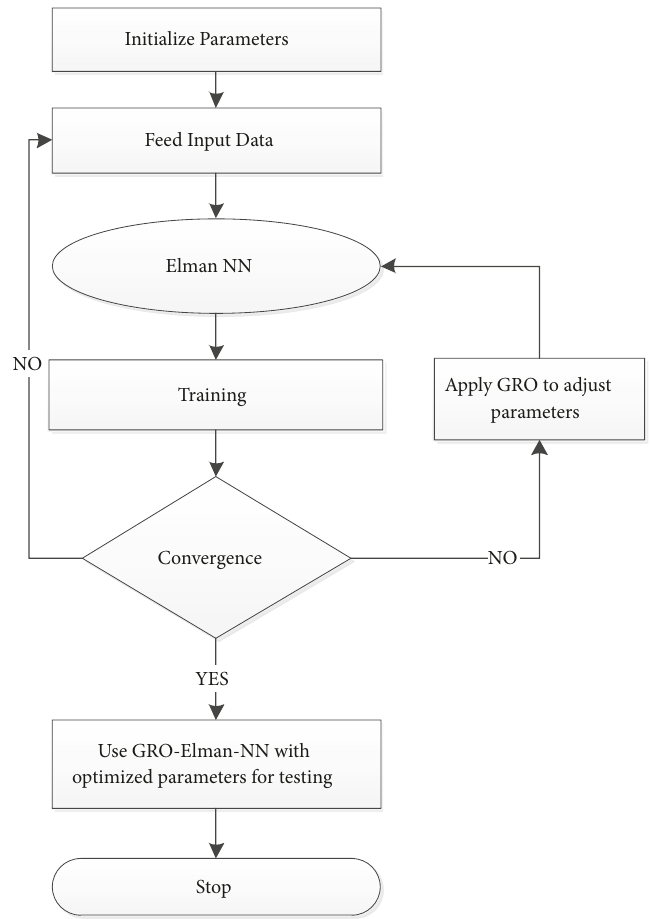
Figure 2: Elman NN optimization process using